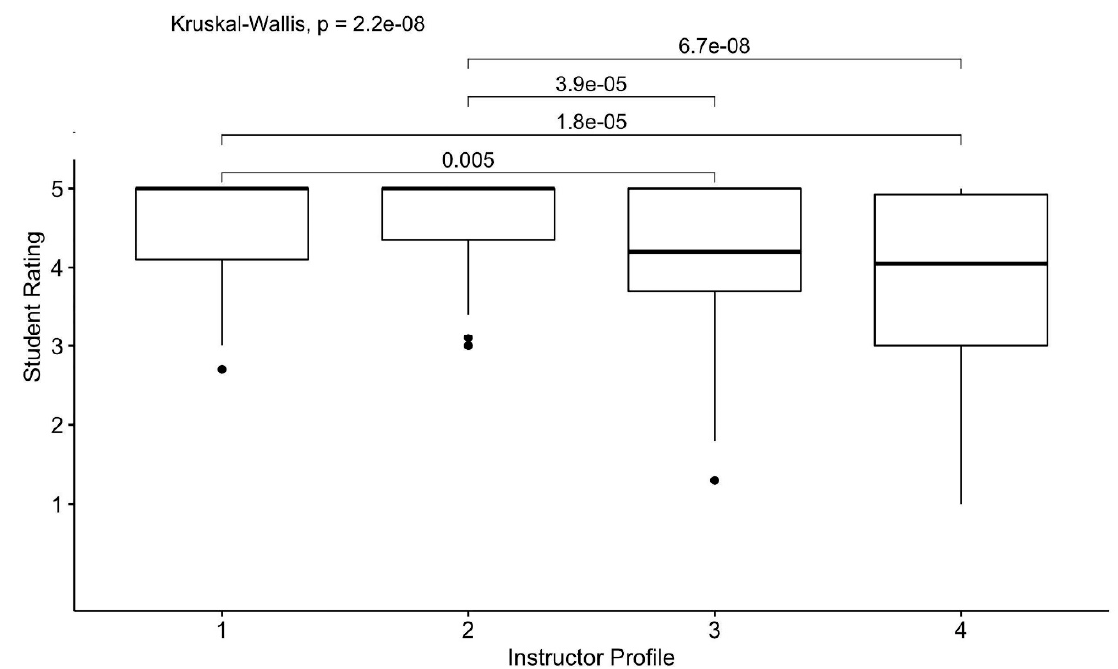
Figure 10. Ratings according to F2F content course type and instructor profile. Instructor 1 is a native speaker from Spain, Instructor 2 is a native speaker from Latin America, Instructor 3 is a Heritage Speaker of Spanish, and Instructor 4 is an L2 Spanish speaker.